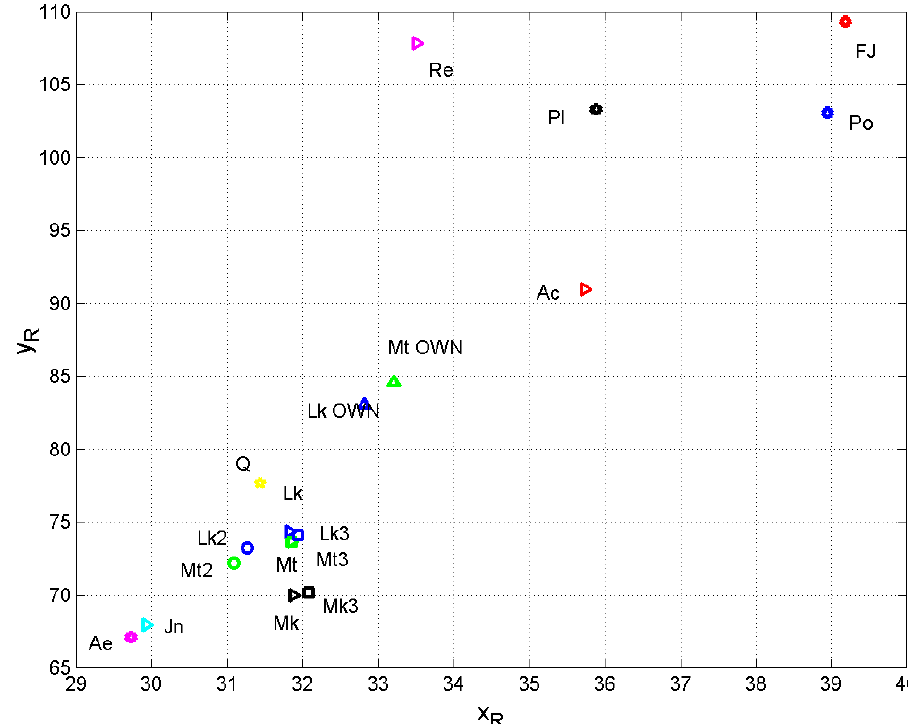
Figure 18. Coordinates x R and y R of the resulting vector (1) of the texts considered. Triangles with vertices to the right refer to Full Texts. Squares refer to the Triple Tradition (e.g., Mt3). Circles refer to the Double Tradition (e.g., Mt2). Triangles with vertices pointing up refer to the Own Tradition.